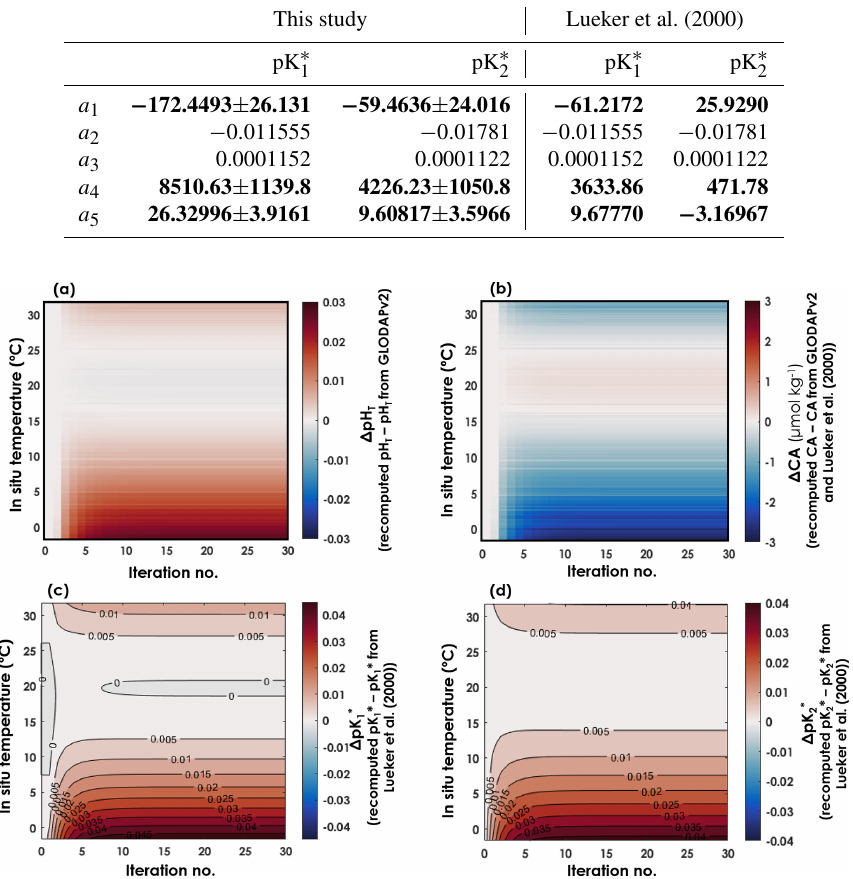
, and pK ∗ as a function of in situ temperature and iterations. (a) Differences between recomputed pH T 1 2 and (d) pK ∗ and the Lueker et al. (2000) values at in situ temperature and at a practical 1 2